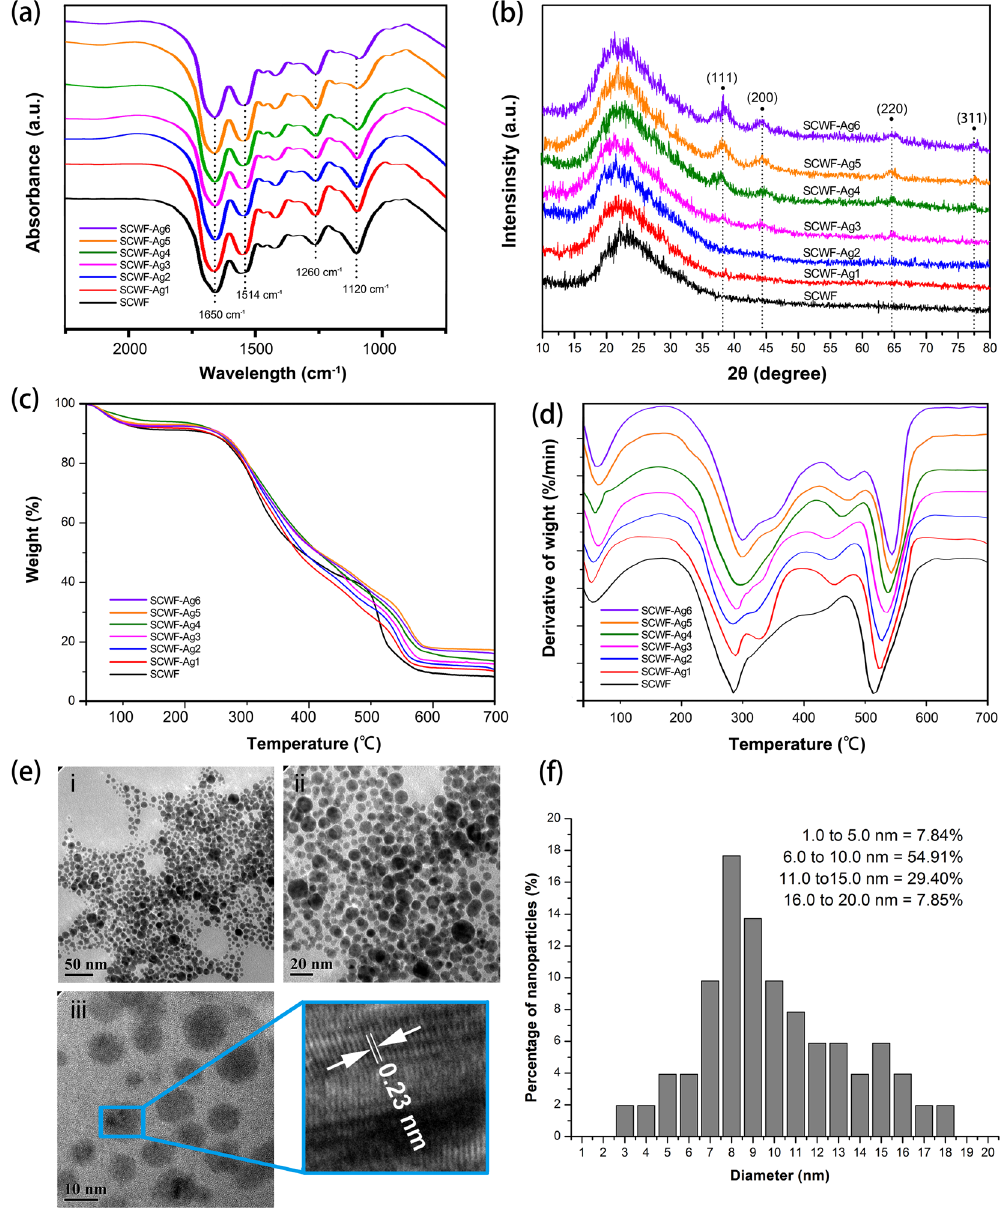
Figure 4. Characterization of SCWF and SCWF-Ag1–6: ( a ) FT-IR absorbance spectra. ( b ) XRD characterization. ( c ) Thermo-gravimetric curves. ( d ) Differential thermal gravity curves. ( e ) TEM images of SCWF-Ag6 at different magnifications of 50 (i), 20 (ii), and 10 nm (iii); ( f ) the corresponding diameter size